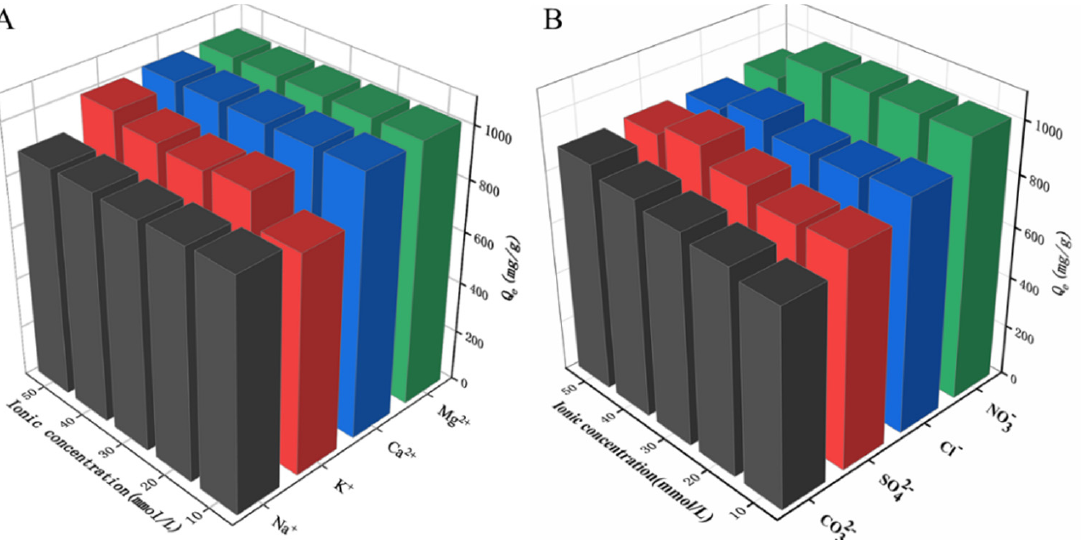
Figure 6. Effect of cations on the adsorption of CR (200 mg L − 1 ) onto N-doped CM-chitin ( A ), and effect of coexisting anions on the adsorption of CR (200 mg L − 1 ) onto N-doped CM-chitin ( B ).